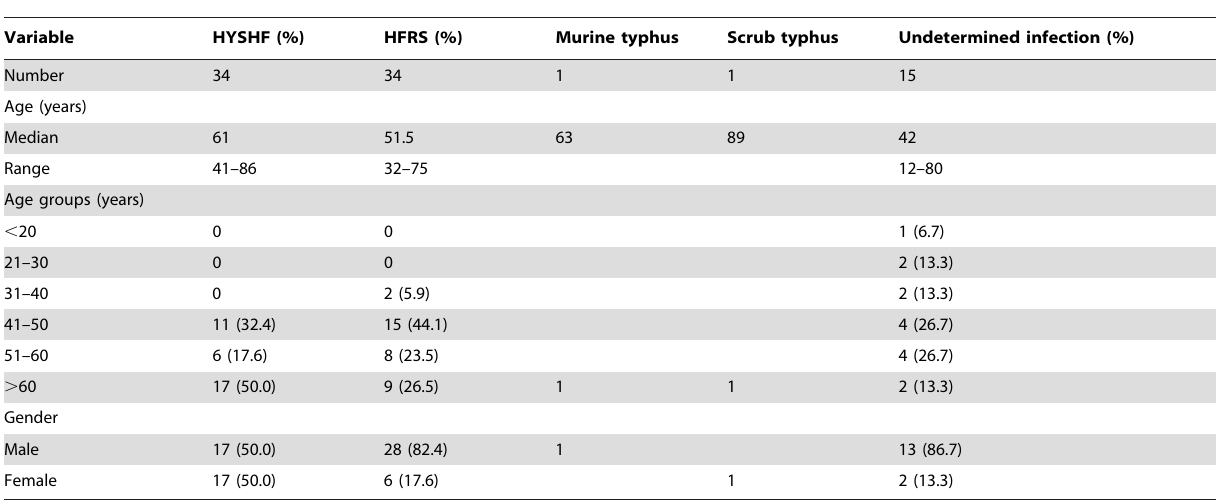
Table 1. Demographic characteristics of 85 patients with HF.